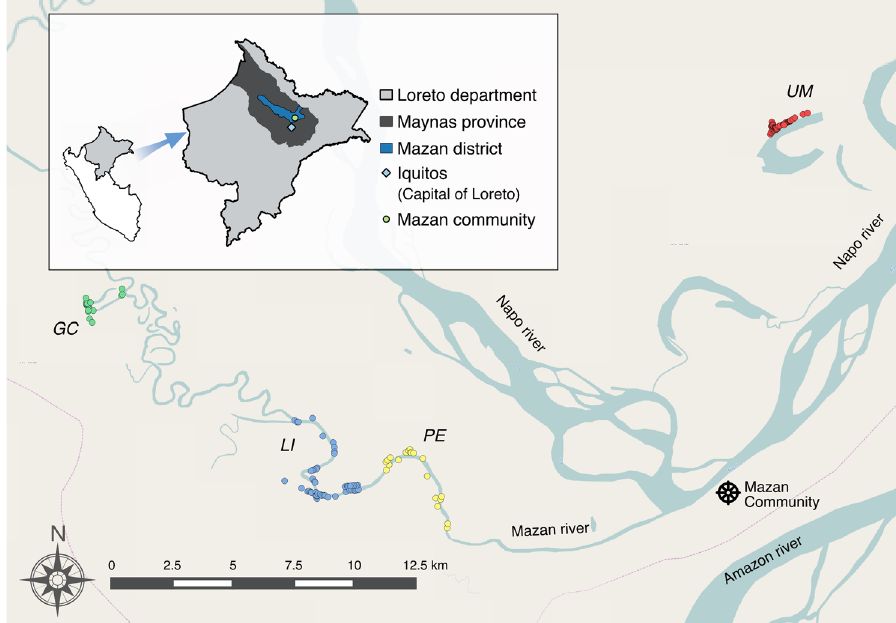
Figure 1. Study area in Mazán district, Loreto Department, Peruvian Amazon. Spatial distribution of Gamitanacocha (GC, green circles), Libertad (LI, blue circles), Primero de Enero (PE, yellow circles) and Urco Miraño (UM, red circles) communities in the Mazan district. Map generated with QGIS 2.16 (QGIS Development Team, 2016. QGIS Geographic Information System. Open Source Geospatial Foundation Project.